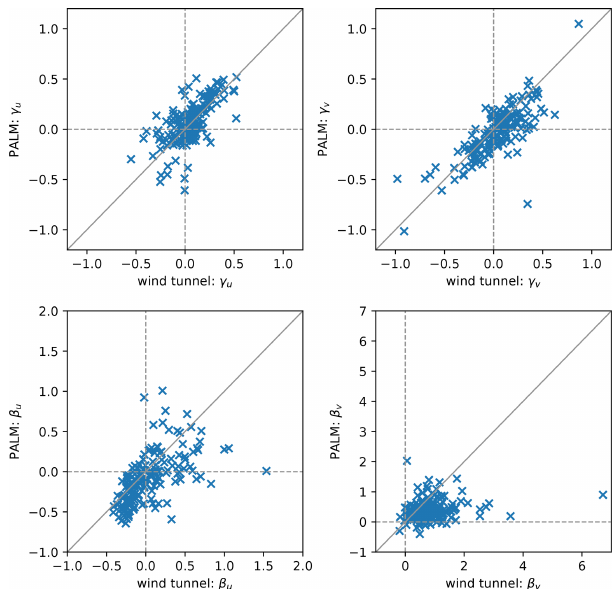
Figure 11. Scatter plots of wind tunnel and PALM measurements of skewness γ and excess kurtosis β of the horizontal wind velocity components for all 25 measurement stations and all heights (173 data pairs in total). Solid lines indicate perfect agreement.